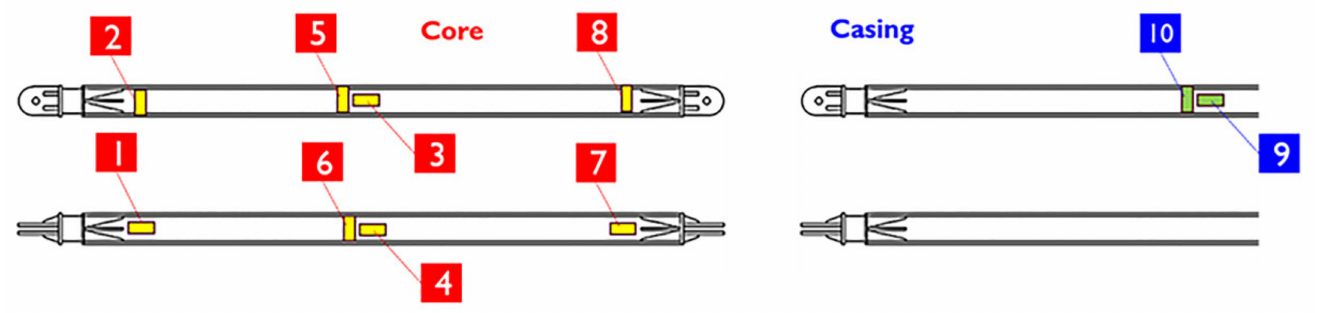
Figure 4. Strain gauge arrangement, orientation, and numbering.